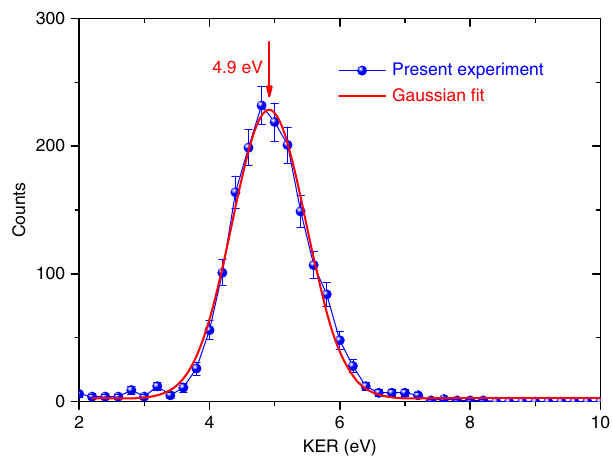
Fig. 3 Calculated potential energy curves for doubly charged cluster N 2 þ Arions. The PECs for T-shaped and linear-shaped N 2 þ 2 the N 2 – Ar bond shown with solid black curve and dashed red curve, respectively. The dimer geometries for T-shaped and linear-shaped structure are schematically